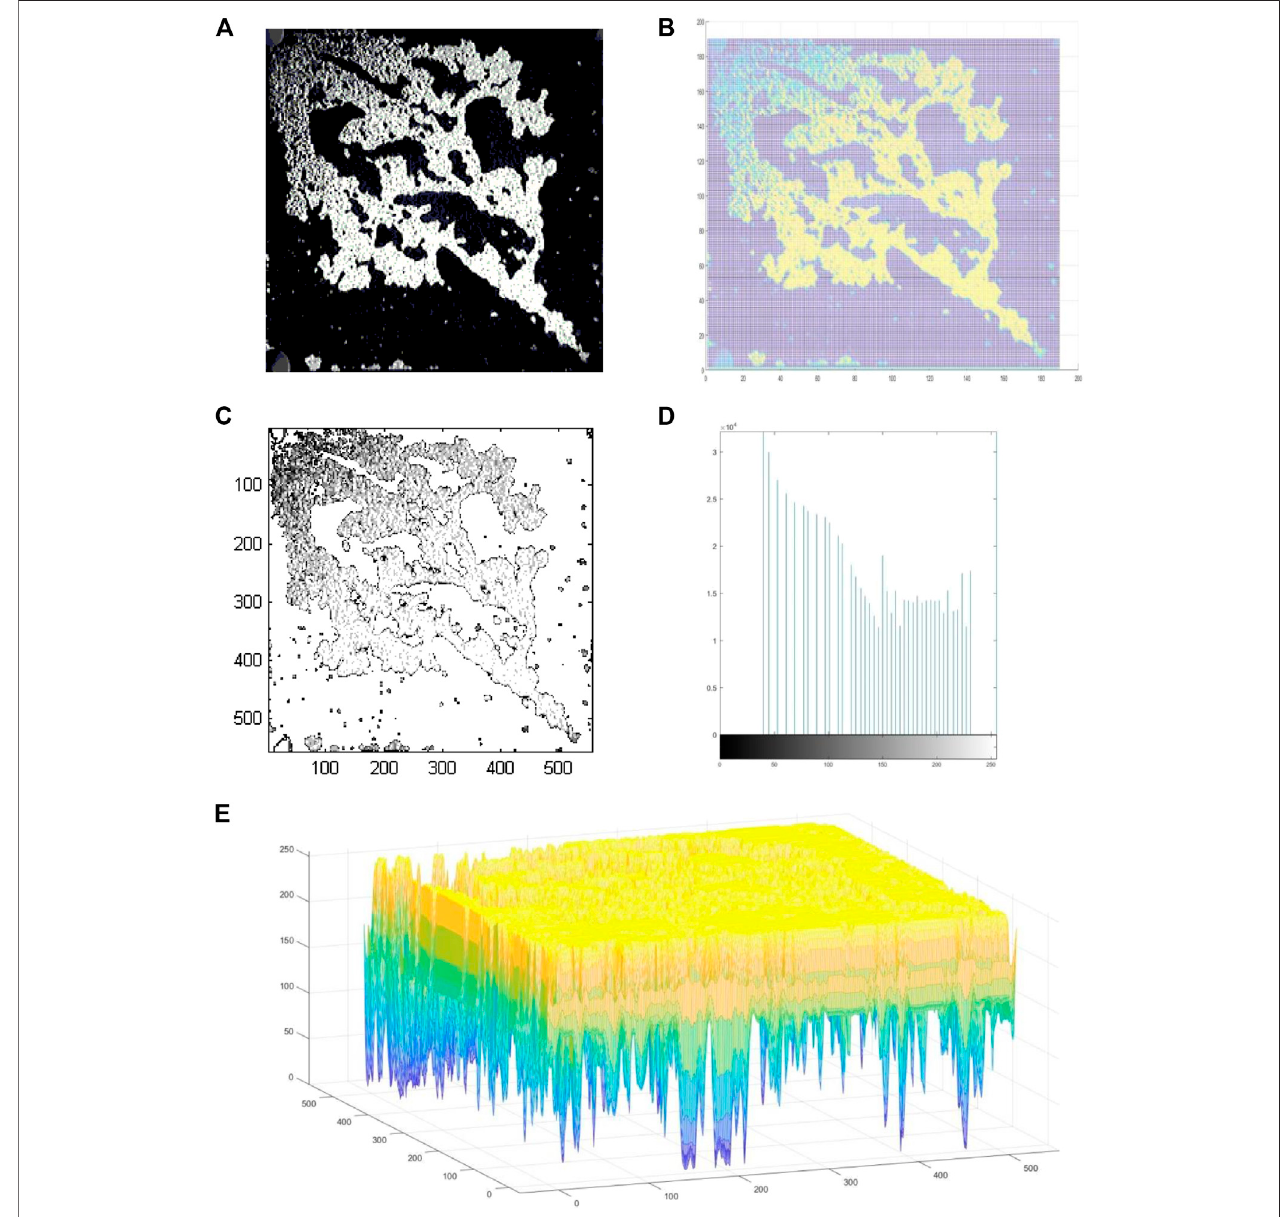
FIGURE 2 | The visualization displacement experiment analyzed by Matlab software. (A) Grayscale image, (B) Pixelated grid image, (C) Edge detection and contour extraction image, (D) Grayscale histogram and (E) Three-dimensional graph.